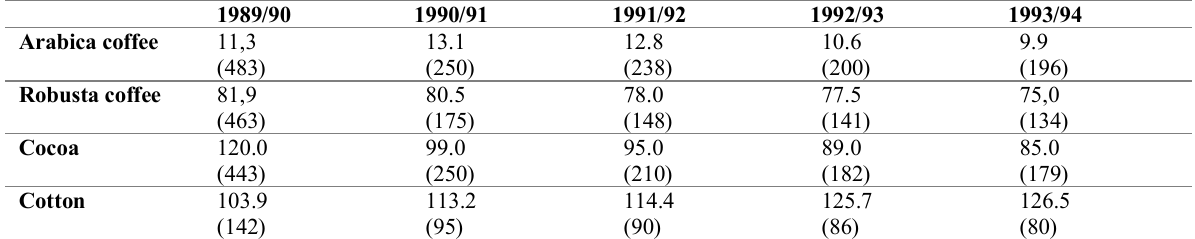
Table 2 : Change in Main Export Crops (thousands of tons) and Their Prices (CFA francs/Kg) 1989/90